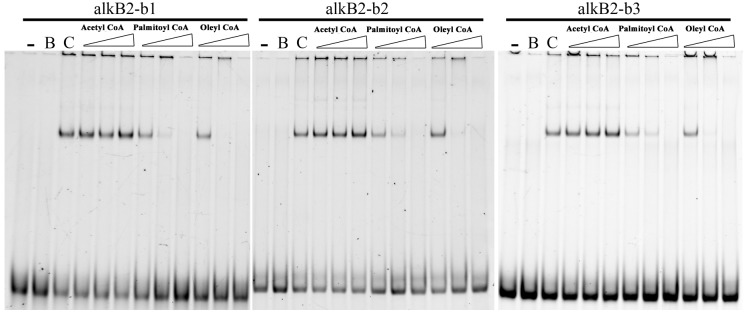
EMSA detection of the alkane metabolites effect on the CrgA binding to different DNA fragments. The fragments of alkB2-b1, alkB2-b2, and alkB2-b3 were used for the target DNA fragments for CrgA protein binding. Acetyl coenzyme A, palmitoyl coenzyme A and oleyl coenzyme A were added into the binding system in 20, 100, and 500 pmol (from left to right). The lane with dash meant the blank control of target DNA fragments. The lane marked B meant the target DNA mixed with BSA protein in 8:1 ratio. The lane marked C was the target DNA mixed with CrgA protein in 8:1 ratio. The input of DNA fragments in each sample was 4 pmol.